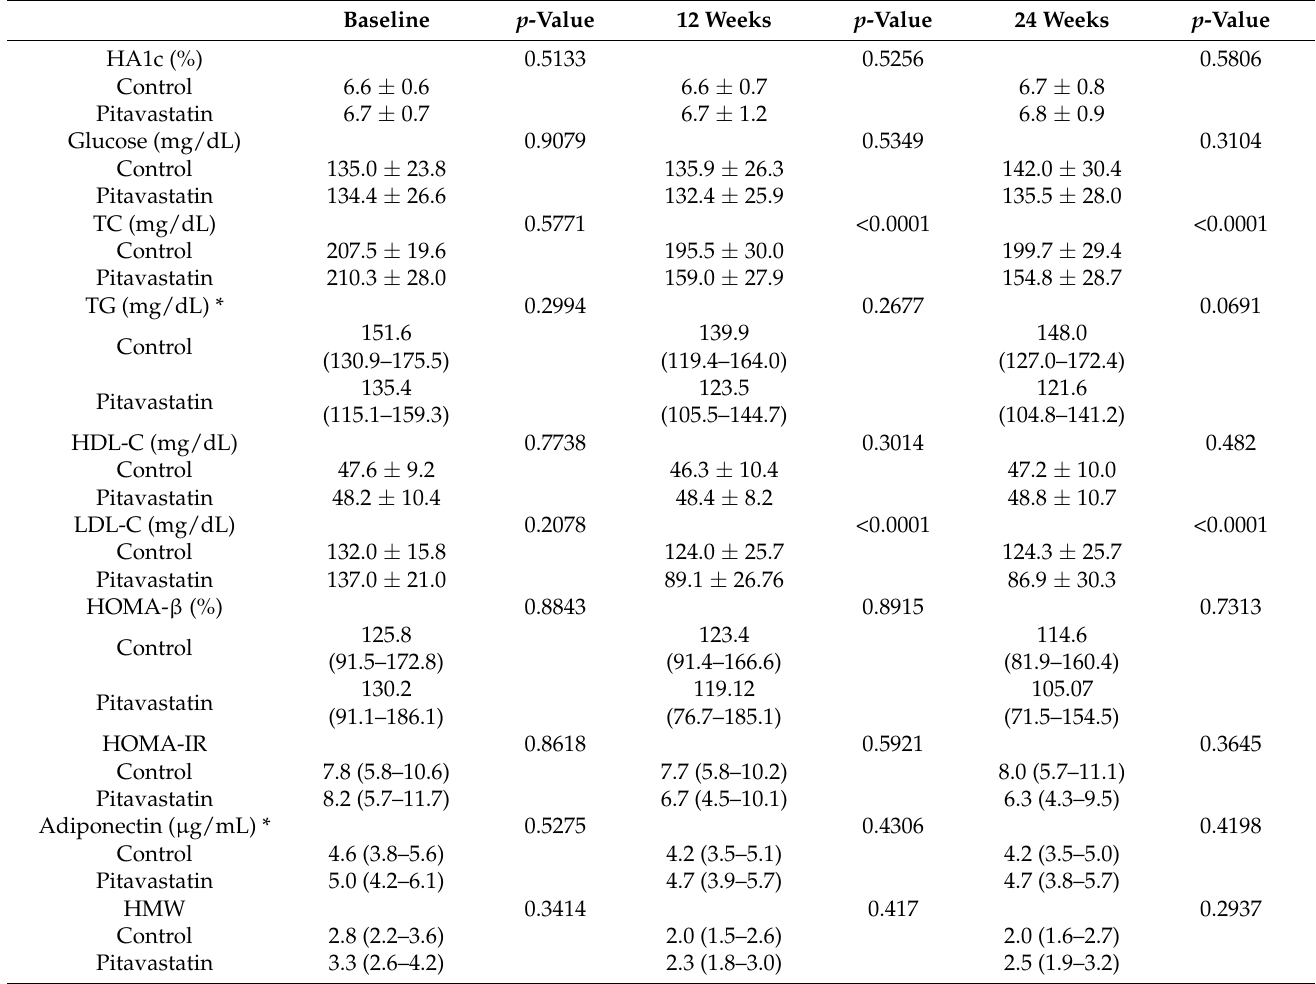
Table 2. The comparison of lipid profile, HOMA-IR, total adiponectin, HMW adiponectin, and after pitavastatin treatment during 24 weeks of